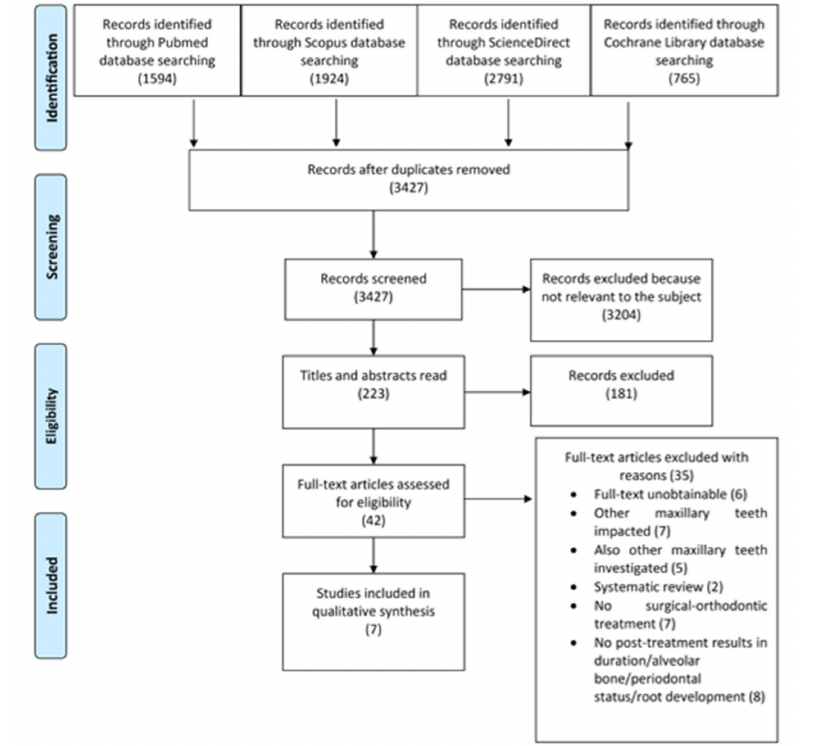
Figure 1. PRISMA flow